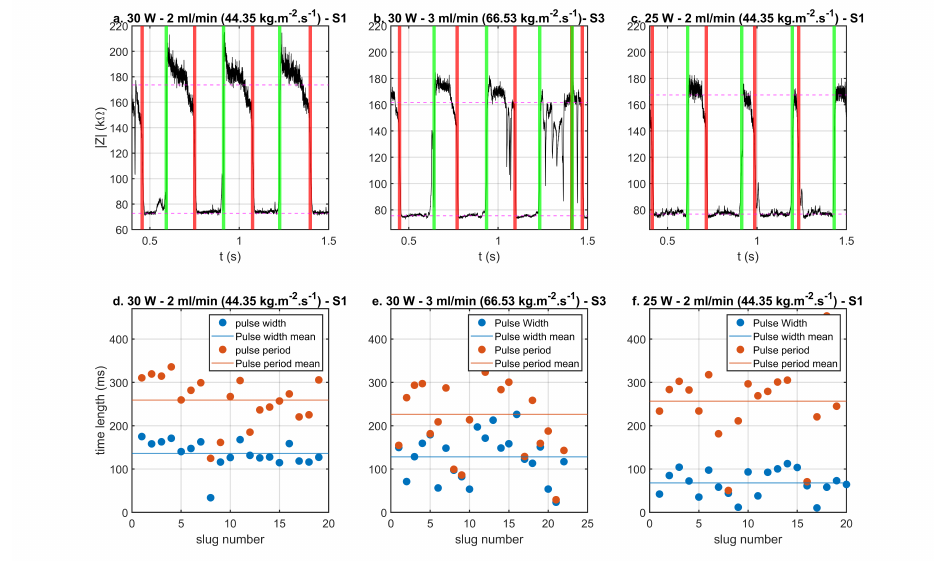
Figure 20. Example of electrical sensing for slug flow. The green vertical lines show the beginning and of the slug and red vertical lines denote end of passing slug. ( a ) impedance amplitude with total power 30 W and flow rate 2 mL/min (44.35 kg ¨ m ´ 2 ¨ s ´ 1 ) ( in S1 location. ( b ) impedance amplitude with total power 30 W and flow rate 3 mL/min (66.53 kg ¨ m ´ 2 ¨ s ´ 1 ) in S3 location. ( c ) impedance amplitude with total power 25 W and flow rate 2 mL/min (44.35 kg ¨ m ´ 2 ¨ s ´ 1 ) in S1 location. ( d ) pulse width and pulse period with impedance amplitude with total power 30 W and flow rate 2 mL/min (44.35 kg ¨ m ´ 2 ¨ s ´ 1 ) in S1 location. ( e ) pulse width and pulse period with impedance amplitude with total power 30 W and flow rate 3 ml/m in S3 location. ( f ). pulse width and pulse period with impedance amplitude with total power 30 W and flow rate 2 mL/min (44.35 kg ¨ m ´ 2 ¨ s ´ 1 ) in S1